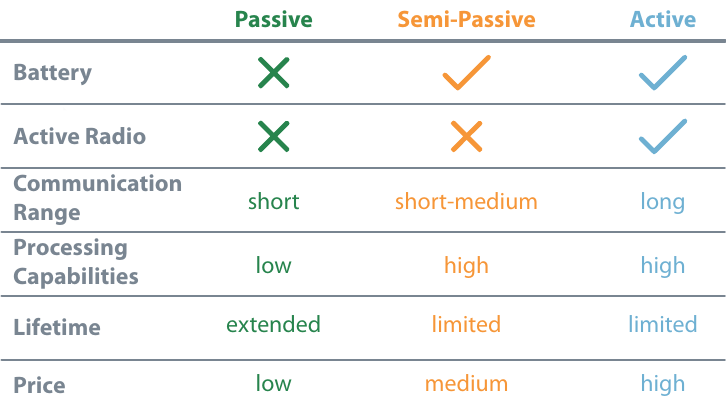
Figure 2. IoT characterization considering energy and